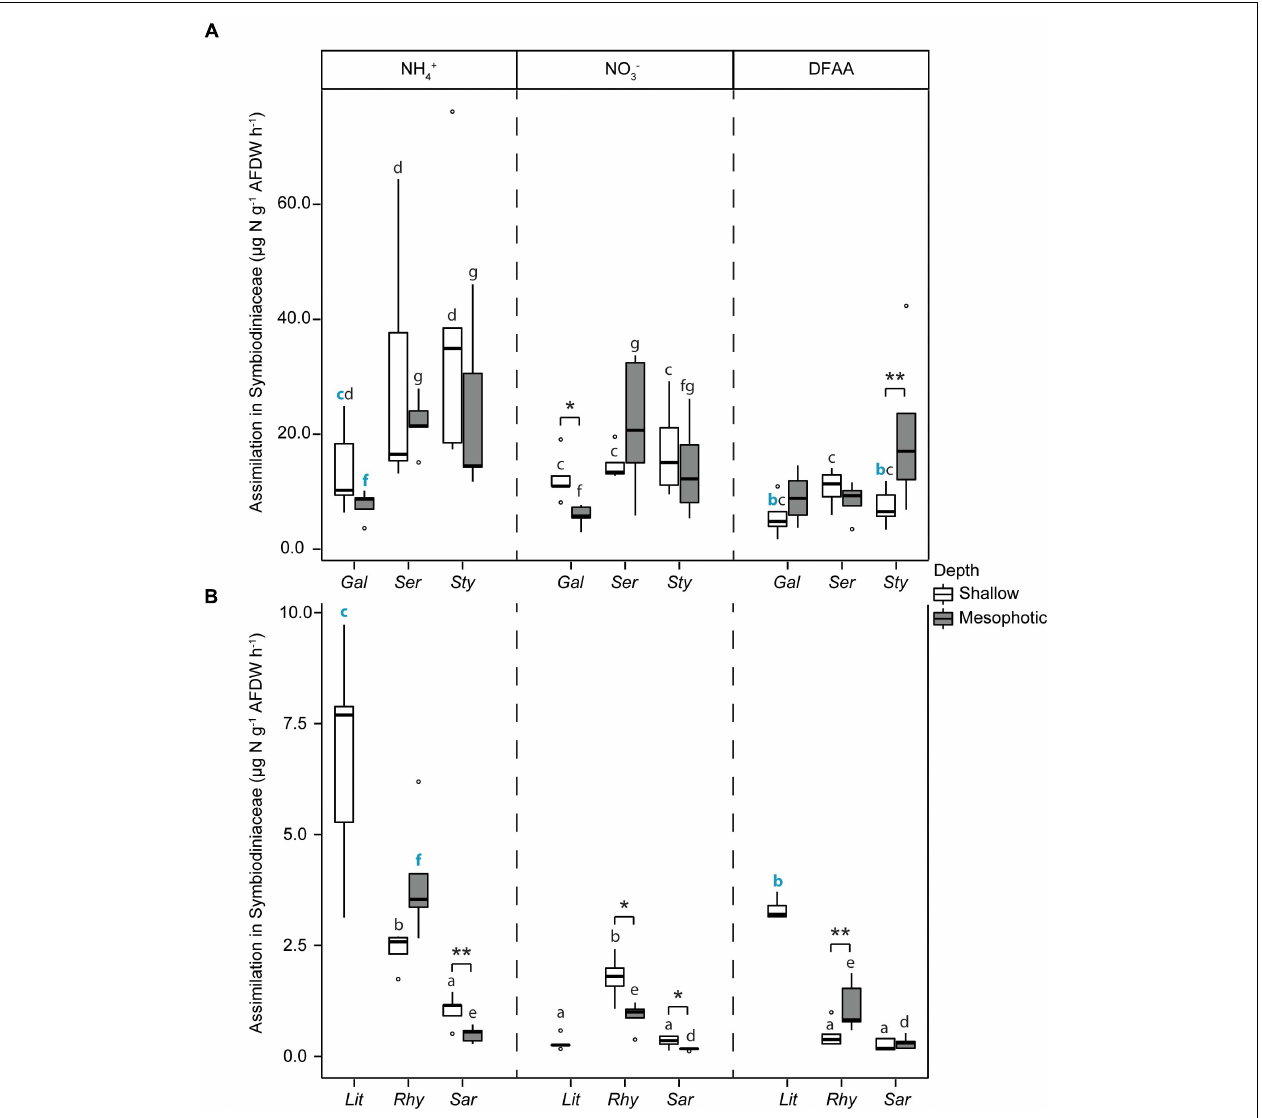
FIGURE 5 | Assimilation rates of dissolved N in the Symbiodiniaceae fraction in (A) hard corals [ Galaxea fascicularis (Gal), Seriatopora hystrix (Ser), Stylophora pistillata (Sty)] and (B) soft corals [ Litophyton arboreum (Lit), Rhytisma fulvum fulvum (Rhy), Sarcophyton sp. (Sar)]. Significant differences between depths are displayed with asterisks (* for p < 0.05; ** for p < 0.01). For each N source taken independently, significant differences between species are distinguished with letters by depth. Blue bold letters highlight a similar rate between hard and soft coral species. AFDW = ash-free dry weight. ns = not sampled. DFAA = dissolved free amino acids. ns = not